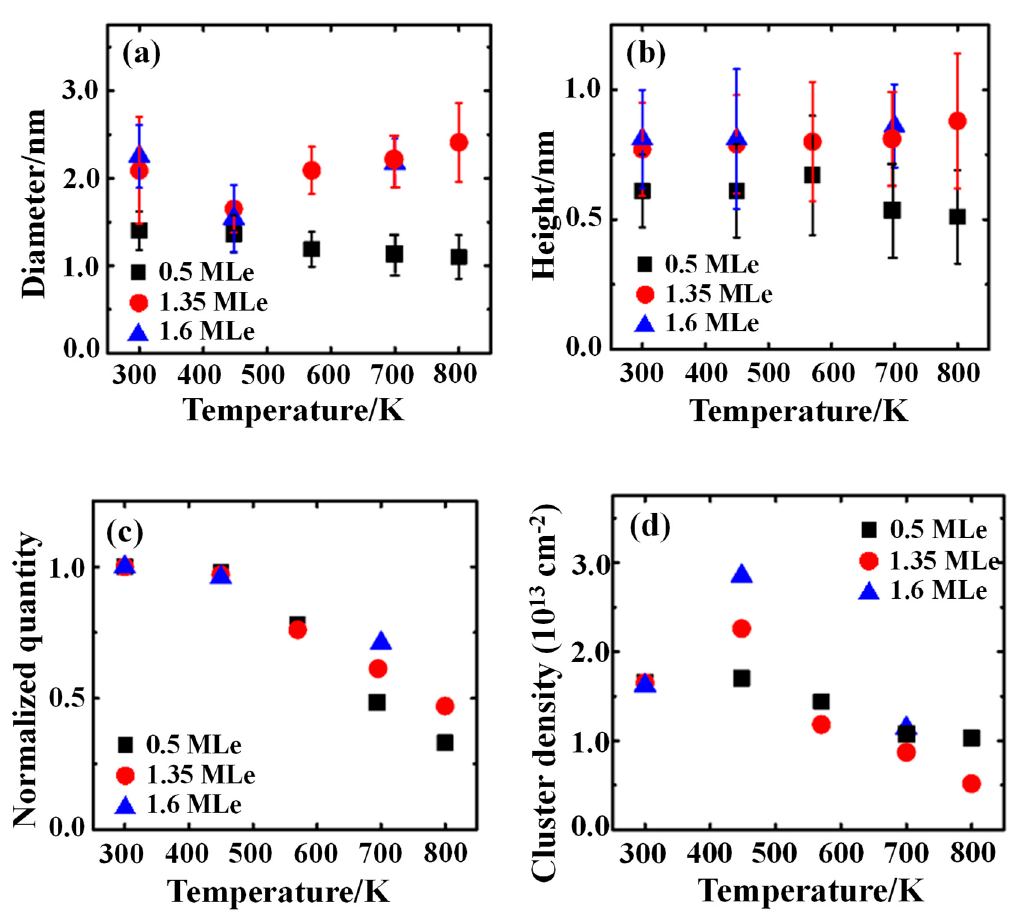
Figure 3. ( a – d ) Plot in order the evolution of the mean diameter, mean height, quantity and density of Rh clusters with temperature. Three Rh coverages, 0.5 (back square), 1.35 (red circle) and 1.6 MLe (blue triangle), are demonstrated. The errors bars in ( a , b ) indicate the full width at half maximum of the Gaussian curves which fit best the histograms of diameter and height of Rh clusters. The quantities in ( c ) were calculated with cluster densities and mean volumes of individual clusters for each Rh coverage; they were normalized to the quantities derived for clusters as prepared.